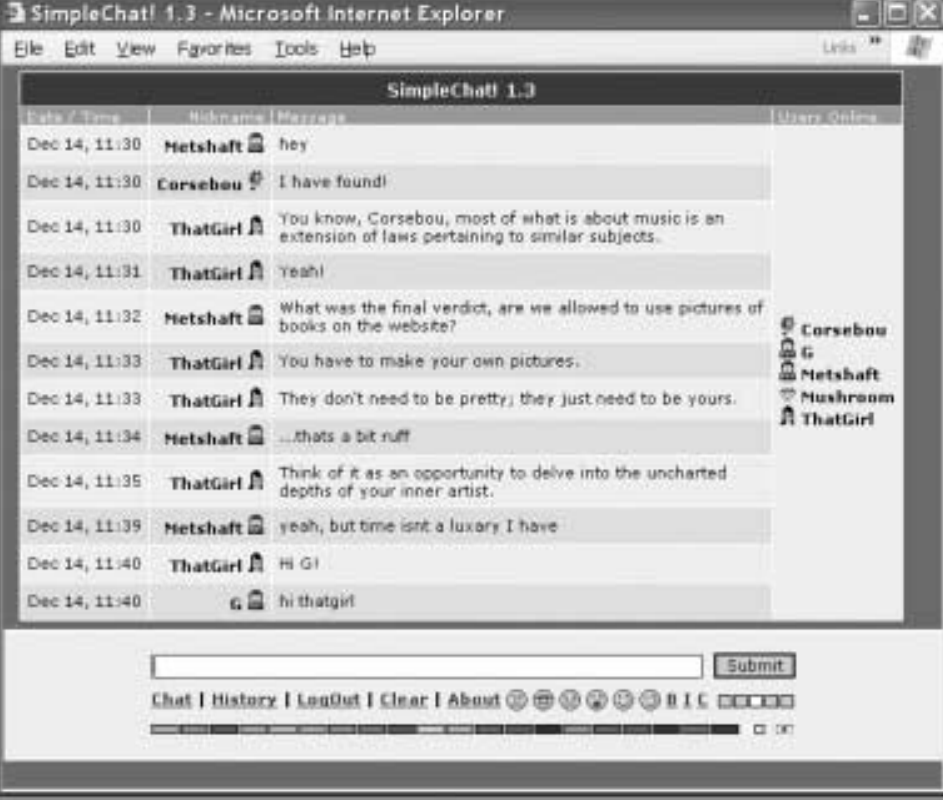
Figure 1. Screen shot of the chat application. The bottom frame is for composing messages. The top frame shows the ongoing dialogue. The column on the right shows who is online at the moment. Note the icons, some of which imply Male and female icons were available, but also ungendered cartoon characters. A